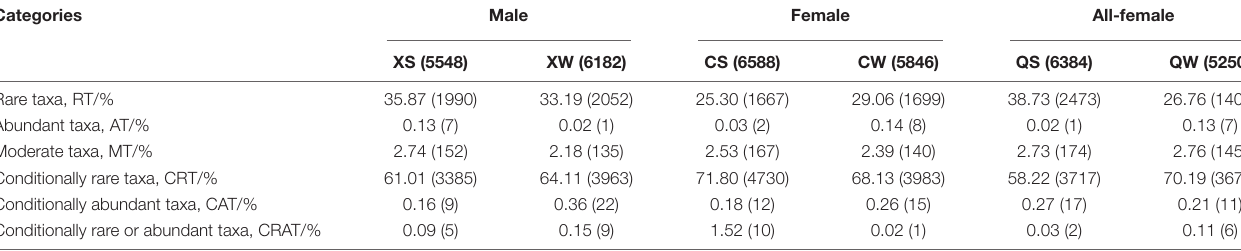
TABLE 4 | Categories of bacterial